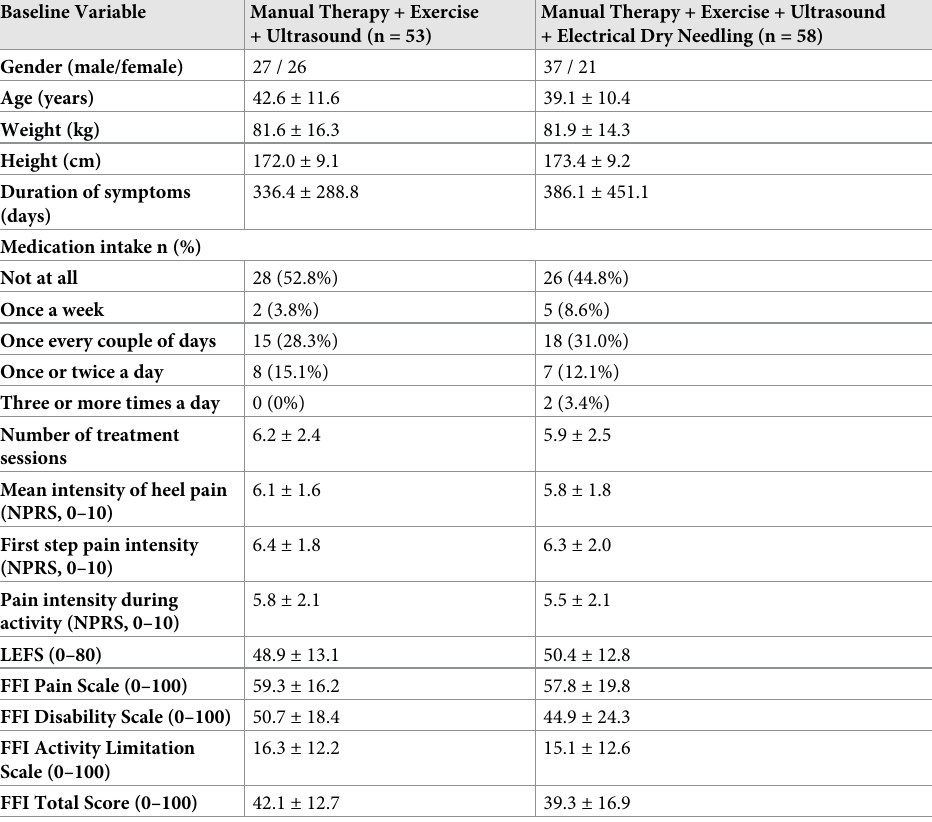
Table 1. Baseline characteristics by treatment